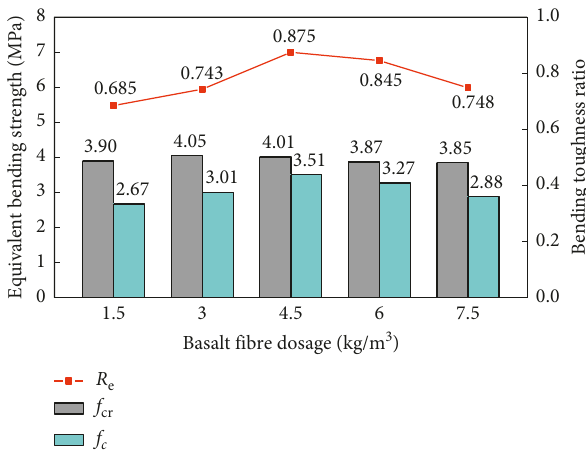
Figure 9: Equivalent bending strength of JSCE